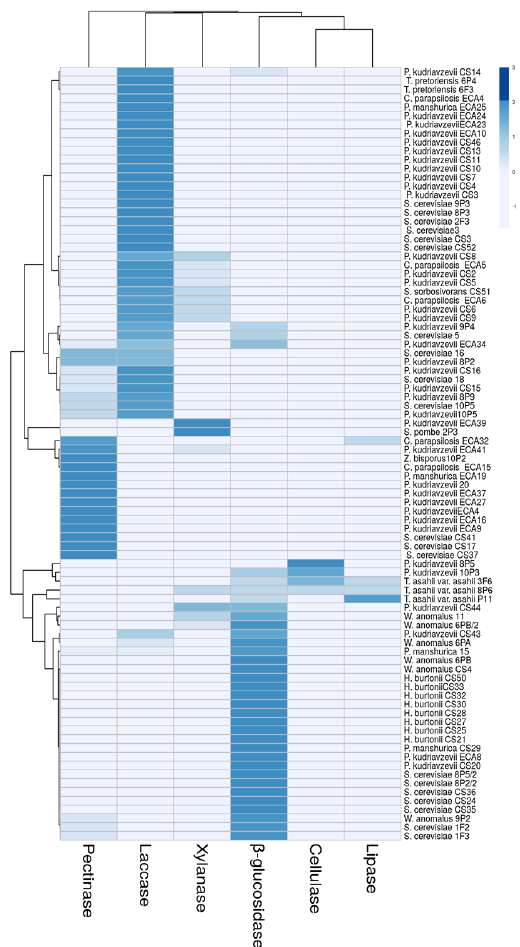
Figure 2. Heatmap showing the extracellular enzyme activity profiles correlation, displayed by the strains isolated from fermented and dry cocoa beans in selective solid medium incubated at 25 °C for 3 days.